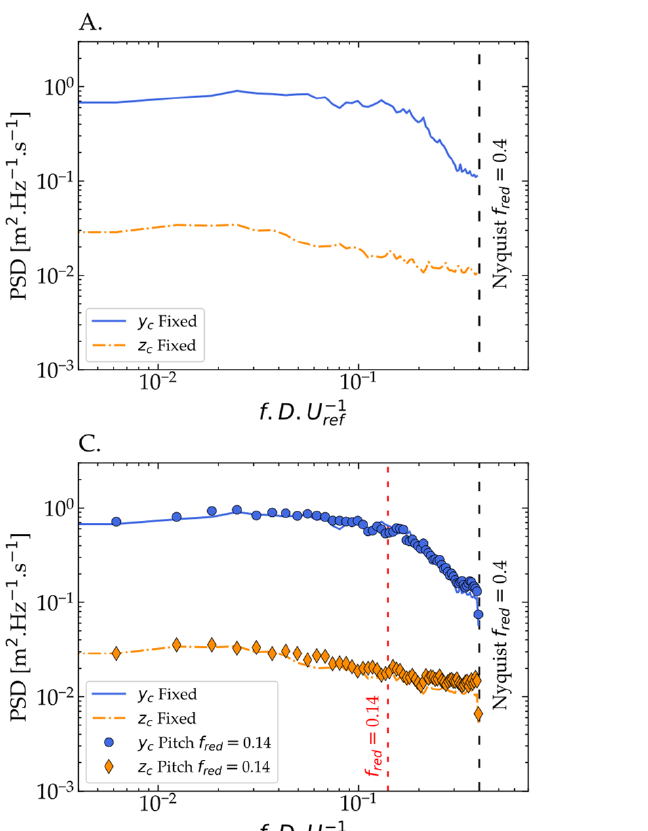
Figure 9. Spectral density spectrum of wake centres for different test cases. ( A ) Fixed model; ( B ) = 0.28; ( C ) Pitch f = 0.14; ( D ) Surge f = 0.11. Pitch f red red red